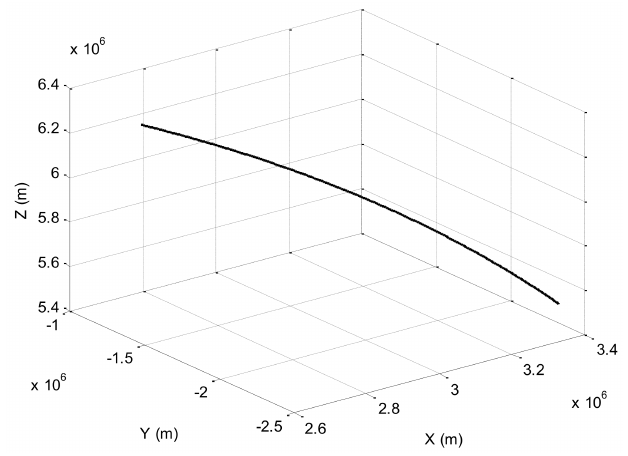
Figure 3. Flight